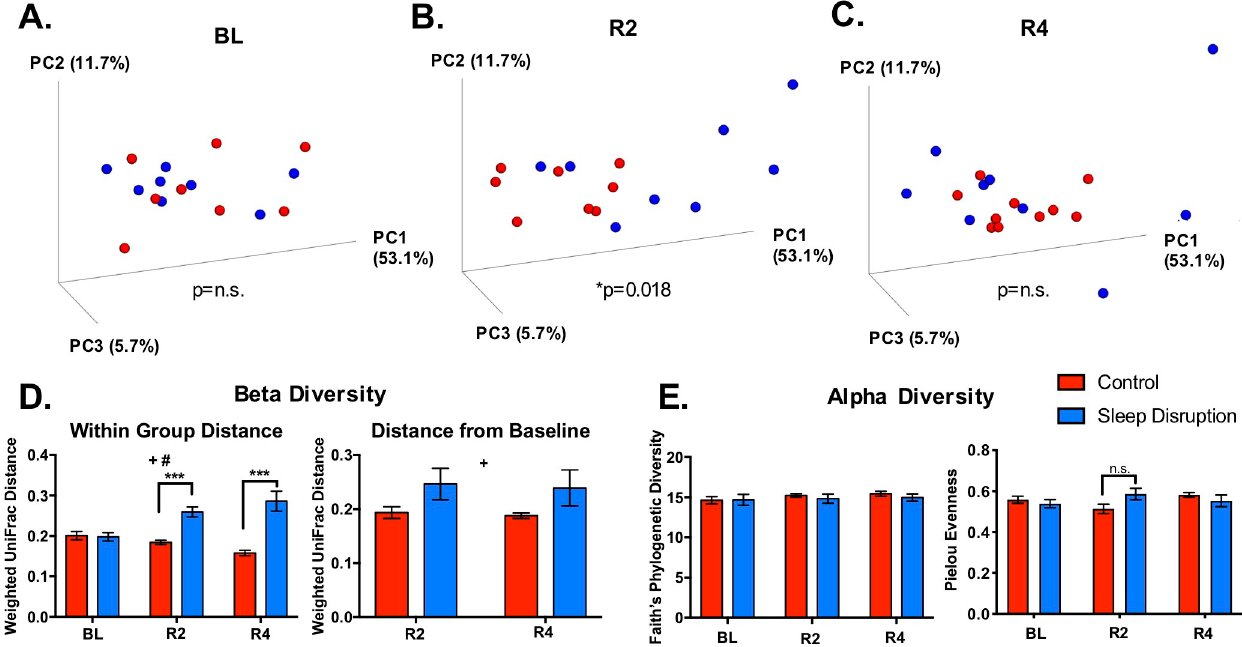
Fig 3. Effect of sleep disruption on microbiome beta and alpha diversity. A-C) Principal coordinates analysis (PCoA) plots using weighted UniFrac distance. A significant difference between sleep disruption and control groups at day 2 post-sleep disruption was detected using PERMANOVA. D) Average weighted UniFrac distance from an individual to all individuals within the same group (left) and from an individual post-sleep disruption to each individual pre-sleep disruption (right) is increased at both day 2 and day 4 post-sleep disruption. E) Faith’s Phylogenetic Diversity (left) and Pielou Evenness (right) were unchanged throughout the experiment. Abbreviations: BL, baseline; R2, day 2 post-sleep disruption; R4, day 4 post-sleep disruption. n = 8-10/group. � p < 0.05 (PERMANOVA); �� p < 0.01, ��� p < 0.001 (Bonferroni post hoc test); + p < 0.05 (Overall effect of Sleep Disruption, Mixed-effects model); # p < 0.05 (Sleep Disruption x Time interaction, Mixed-effects model).